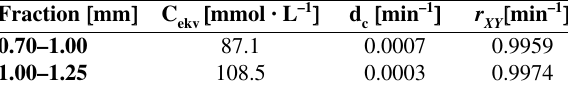
Table 6 . Kinetic parameters and correlation